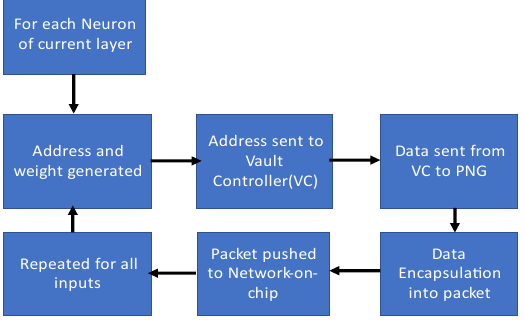
Figure 4. Proposed programming and execution of a NN in Neurocube [4].